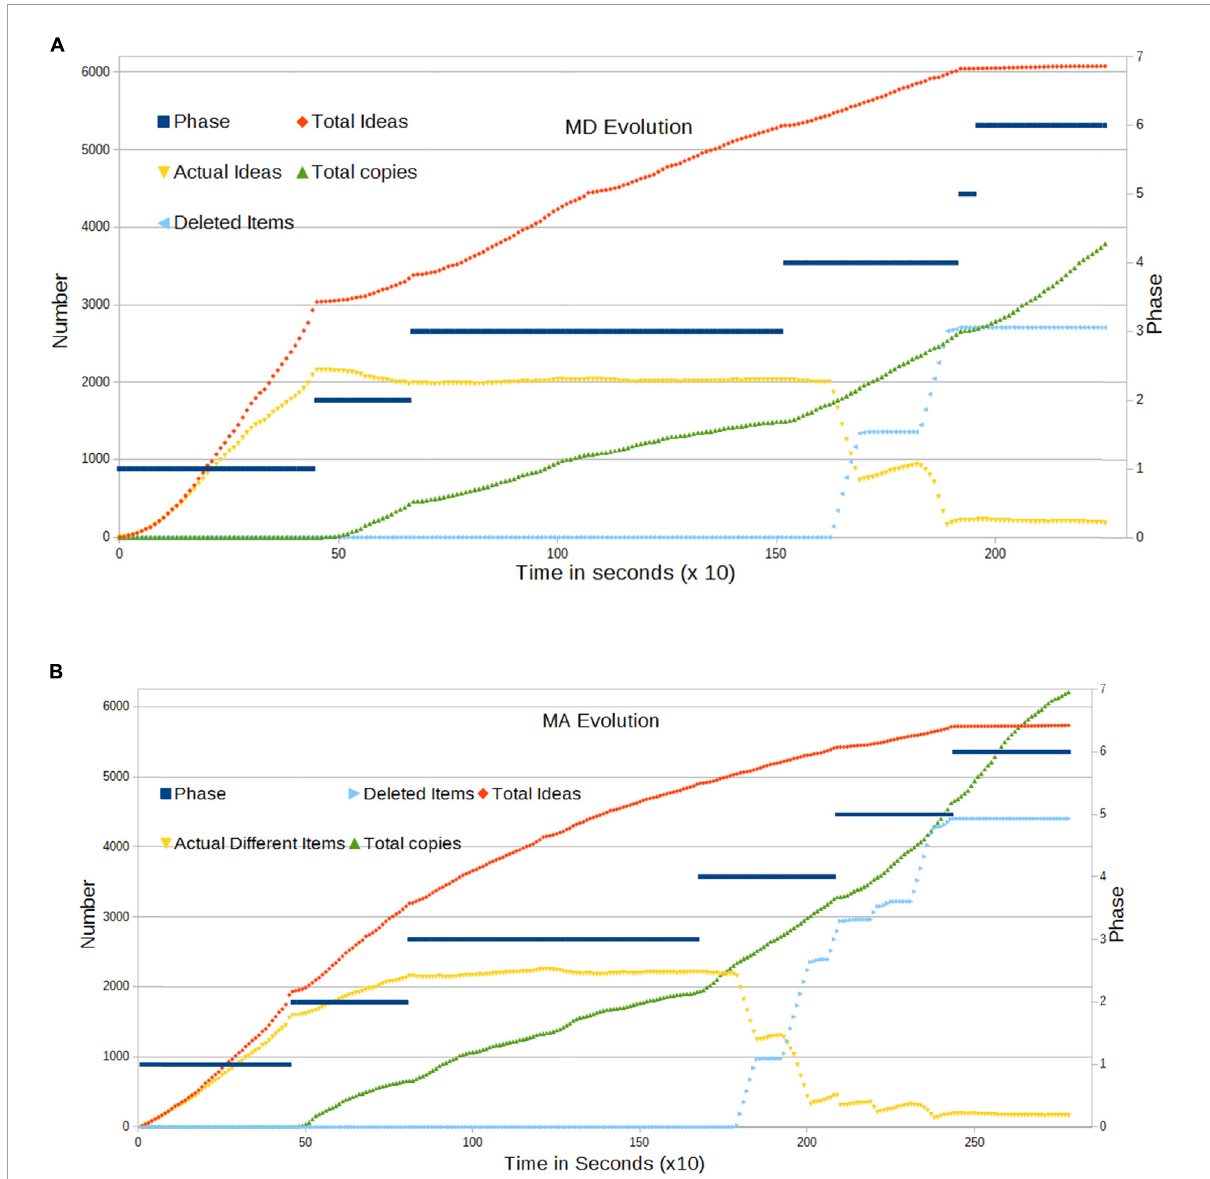
FIGURE3 (A) Evolution of activity in the MD examination. The dark blue line shows the phase at each moment (right Y axis). Students’ activity corresponds to the red, yellow, and green lines. The light blue line stands for the items deleted for purposes of dynamics. The time unit is 10 s. (B) Evolution of activity in the MA examination. The dark blue line shows the phase at each moment (right Y axis). Students’ activity corresponds to the red, yellow, and green lines. The light blue line stands for the items deleted for purposes of dynamics. The time unit is 10